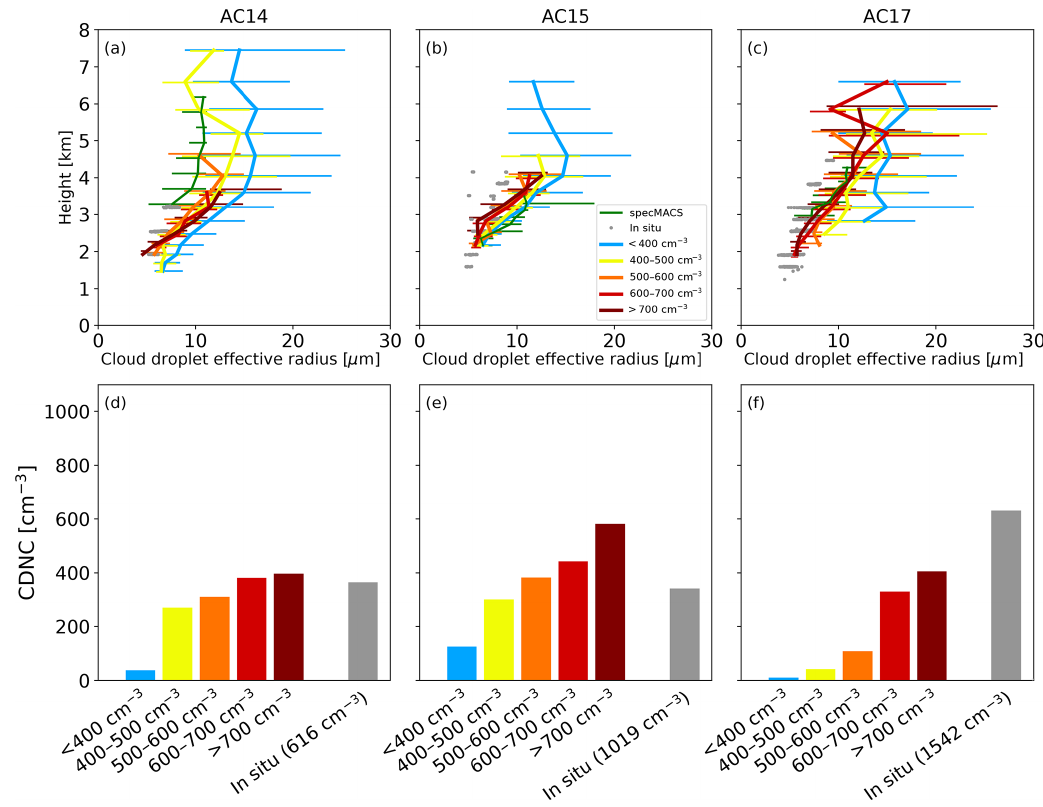
Figure 5. r eff profiles and associated cloud droplet number concentration (CDNC) on 3d during the field campaign. (a–c) show a comparison of median WRF-Chem, specMACS, and in situ r eff profiles. (d–f) show the “true” below-cloud CCN-binned CDNC from WRF-Chem simulations and CDNC from in situ cloud profiling. Average in situ CCN concentrations (below 2km) are presented at the bar label for the in situ-derived N a . See Sect. 3.1 for details regarding the definition of